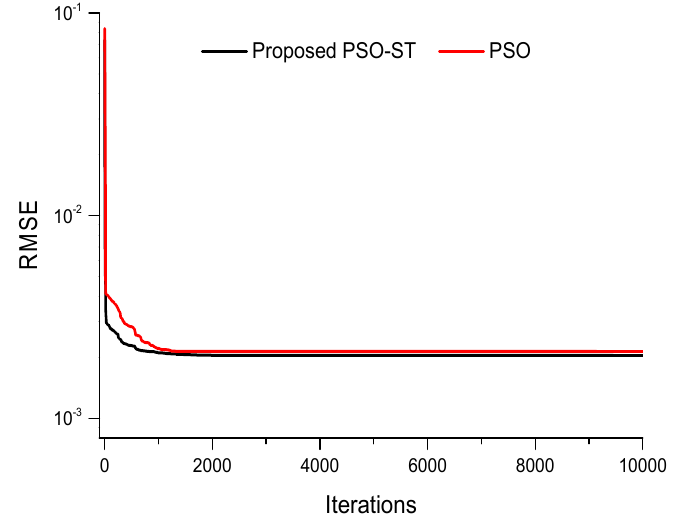
Figure 12. Convergence characteristics of DDM, PV module. Table 10. Obtained statistical results of SDM JKM330P-72 PV module for curve 1. Obtained Optimal Parame-